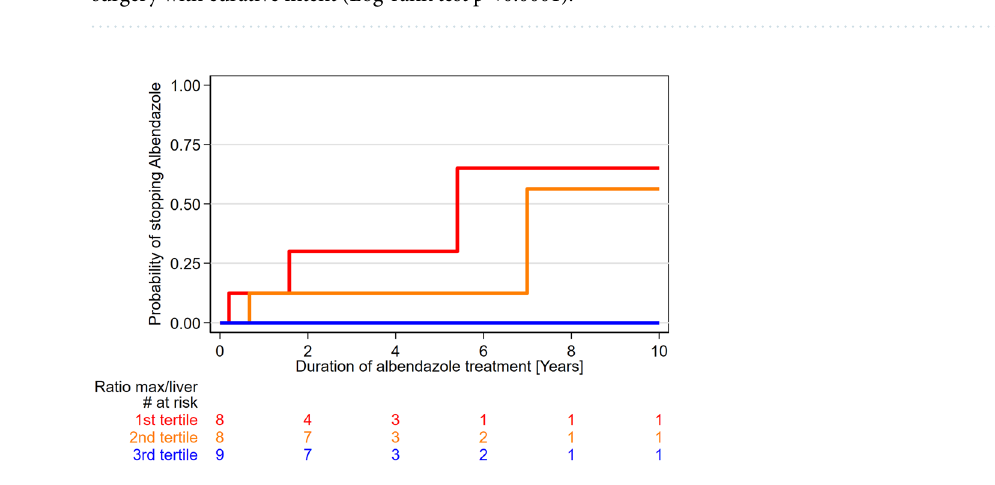
Figure 3. The probability of stopping benzimidazole (i.e. albendazole) therapy is higher if patients underwent surgery with curative intent (Log-rank test p < 0.0001).